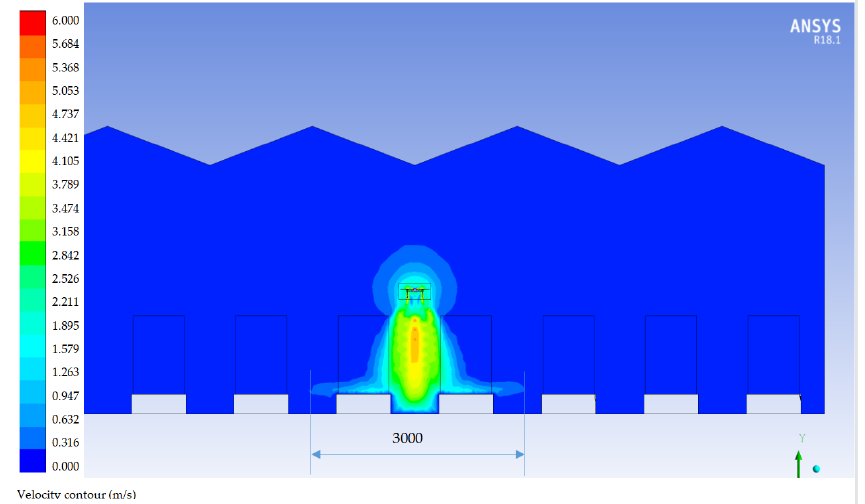
Figure 7. Y–Z velocity distribution.